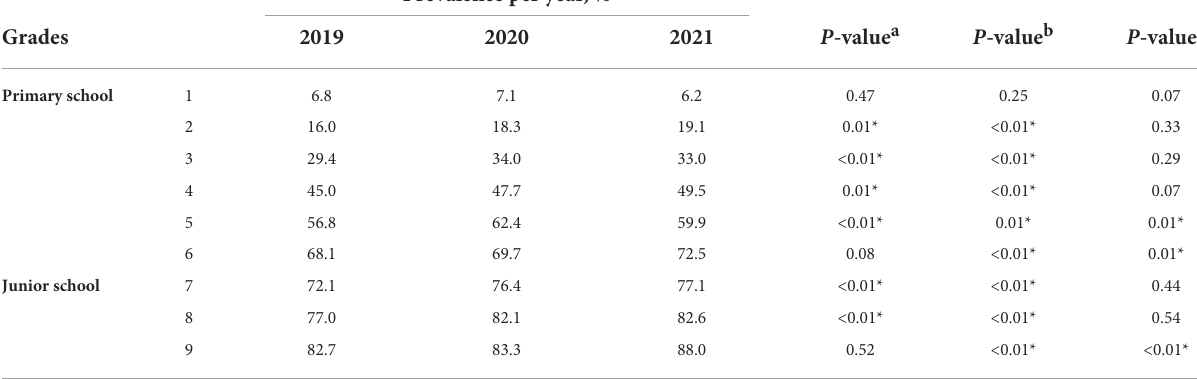
TABLE 3 Prevalence of myopia (SER ≤ − 0.5D) from grades 1 to grade 9 over the 3 years.